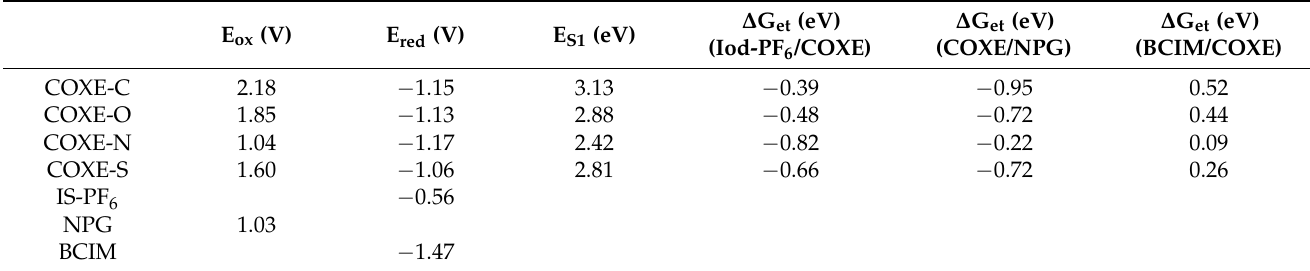
Table 4. Redox potentials (E ox , E red ), excited state energy in the ground state (E S1 ) for COXEs, Gibbs free energy changes in the ground state ( ∆ G et ) data for Iod-PF 6 /COXEs and COXEs/NPG systems. The reduction potential of Iod-PF 6 was − 0.56 V [54], the oxidation potential of NPG was 1.03 V [65] and the reduction potential of BCIM was − 1.47 V [66], which were used for ∆ G et calculations.